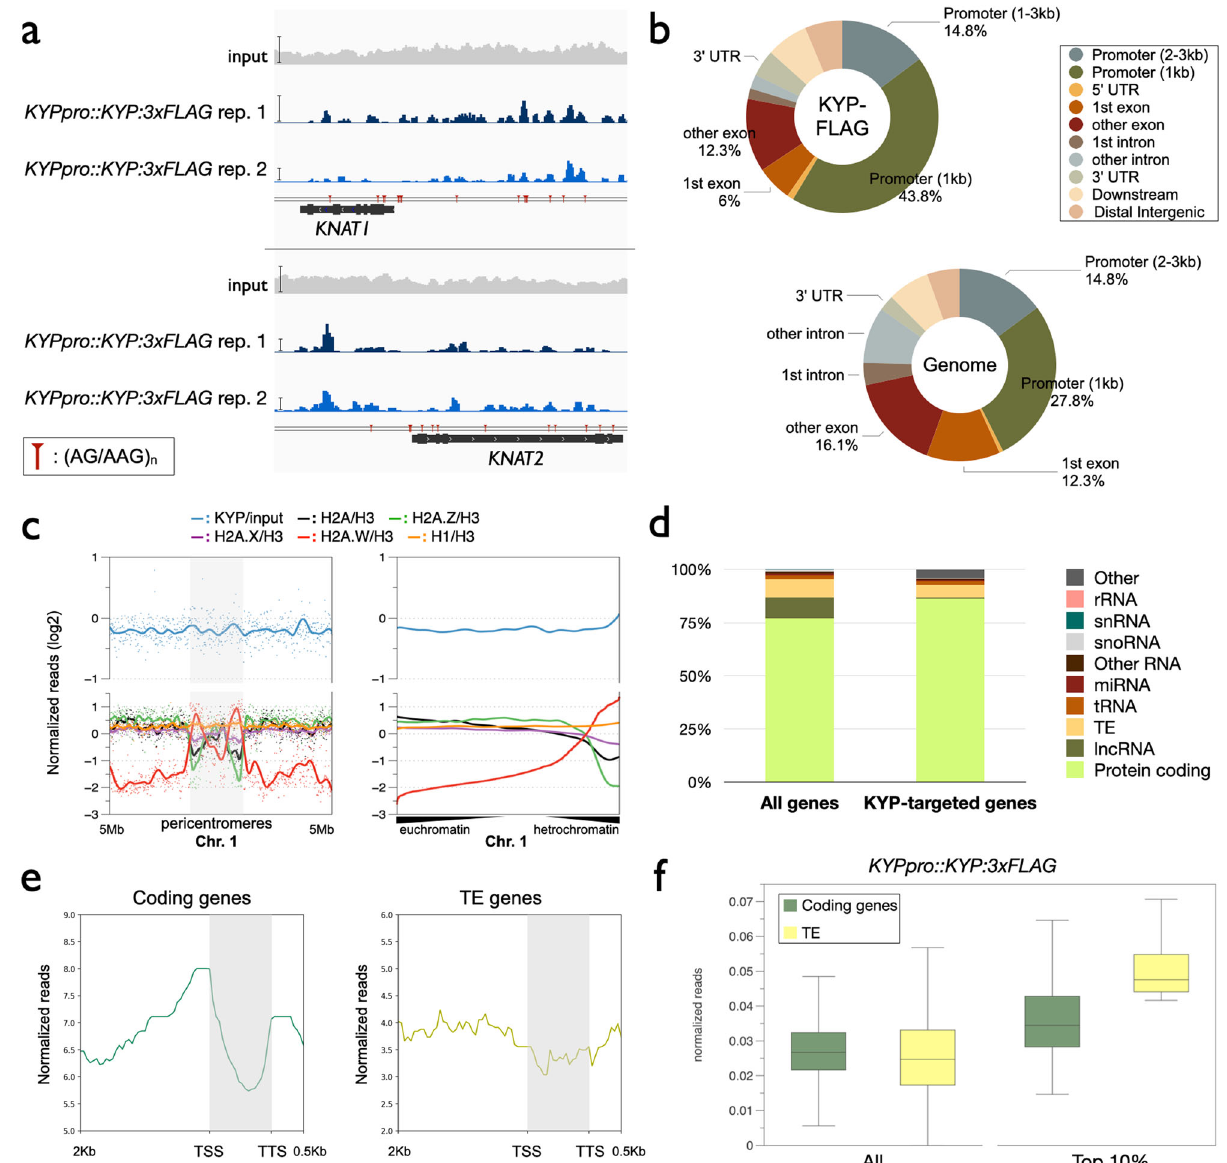
Fig. 5 Genome-wide occupancy pro fi le of KYP. a Integrated Genome Viewer showing the binding of KYP on KNAT1 and KNAT2 genomic regions. Bars: normalized reads = 40. b Pie charts showing the distribution of KYP annotated genic and intergenic regions in the genome. c Plotpro fi le showing the occupancy rates of KYP, H2A, H2A.Z, H2A.X, H2A.W and H1 near the hetrochromatic region of chromosome 1 (Chr. 1). The dots indicated the log2 value of normalized reads, and the lines indicated smoothed patterns of each marker. d Distribution of gene types among all of the KYP-targeted genes. e Metagene ChIP-seq binding pro fi les of KYP among all coding genes and TE genes within the Arabidopsis genome. The pro fi le is from 2 kb upstream of the TSS to 0.5 kb downstream of the TTS, and the gene lengths were scaled to the same size. f Boxplots showing the binding of KYP:FLAG in coding genes and TEs . All annotated coding genes ( n . = 27420) and TEs ( n . = 31189), or top 10% KYP:FLAG highly targeted coding genes ( n . = 2742) and TEs ( n . = 3119) were